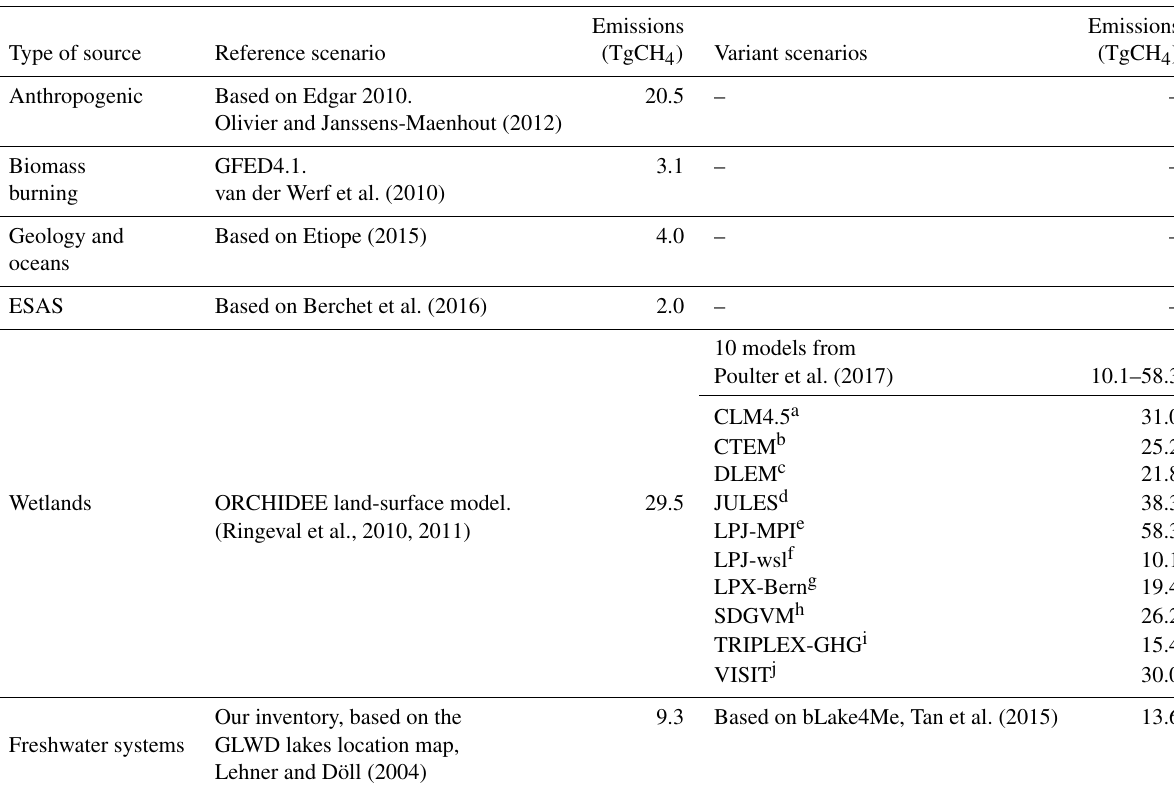
Table 2. Methane emissions in the studied polar domain, for the reference simulation, and for other scenarios. Total emissions for the reference scenario amount to 68.5TgCH 4